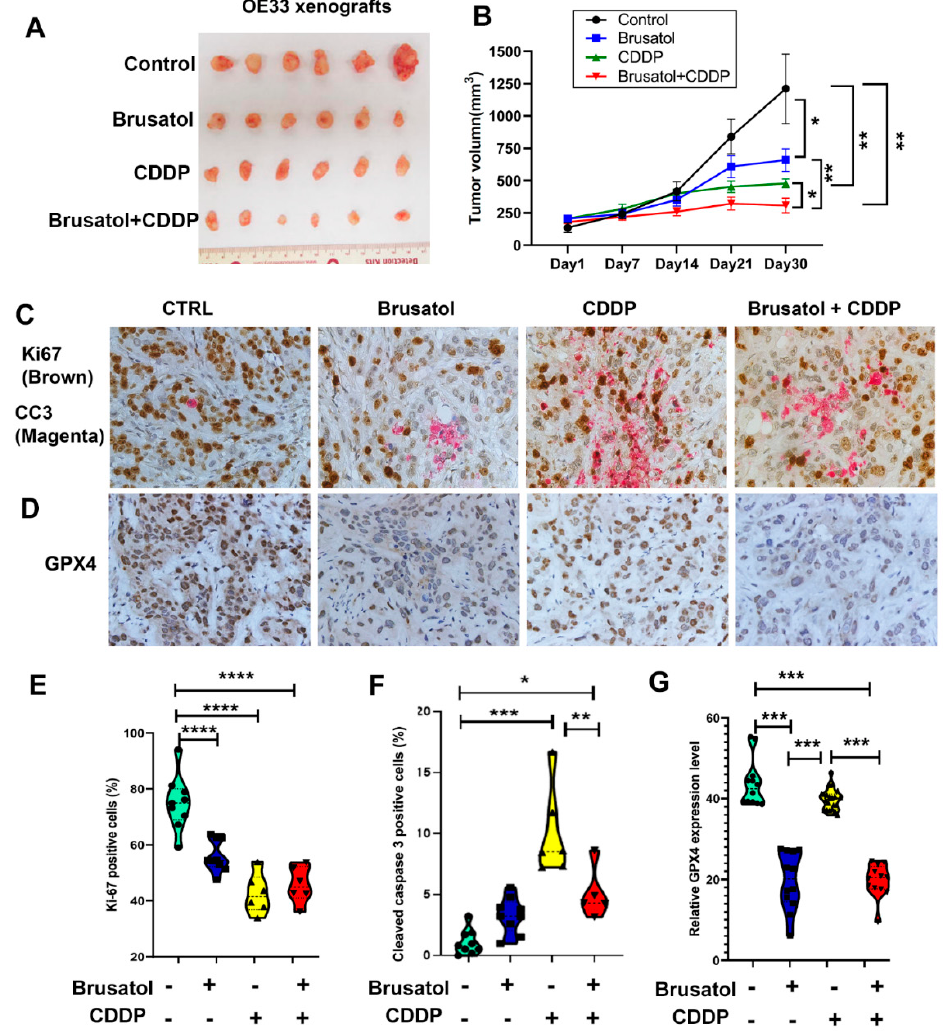
Figure 7. Brusatol synergized with CDDP in killing tumor cells in vivo. ( A ) Representative images of xenogrfting tumors after 30 days of treatments of Brusatol, CDDP, or Brusatol + CDDP. ( B ) The tumor growth curve shows that Brusatol and CDDP alone significantly slowed tumor growth, but the Brusatol and CDDP combination generated the most suppressive effect. ( C ) Dual immunohistochemistry staining of the cell proliferation marker (Ki-67, brown) and apoptosis marker (cleaved caspase 3, magenta) in the xenografted tumor tissues. The quantitative data using ImageJ software are shown in ( E ) (Ki-67) and ( F ) (cleaved caspase 3). ( D ) Immunohistochemistry staining of ferroptosis marker, GPX4, in xenografted tumor tissues shows the significant downregulation of GPX4. The quantitative data using ImageJ software are shown in ( G ). *, p < 0.05; **, p < 0.01; ***, p < 0.001; ****, p < 0.0001.